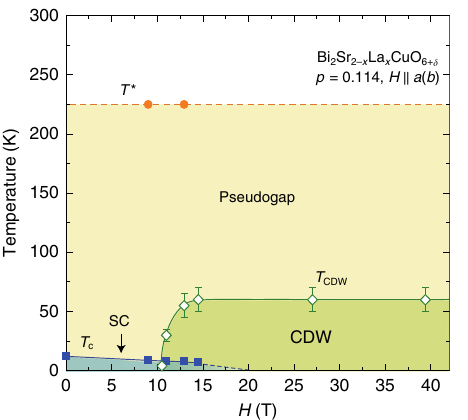
Fig. 3 H - T phase diagram for underdoped Bi2201. The T * is the pseudogap temperature determined from the spin-lattice relaxation rate results. Error bars represent the uncertainty in de fi ning the onset temperature T CDW